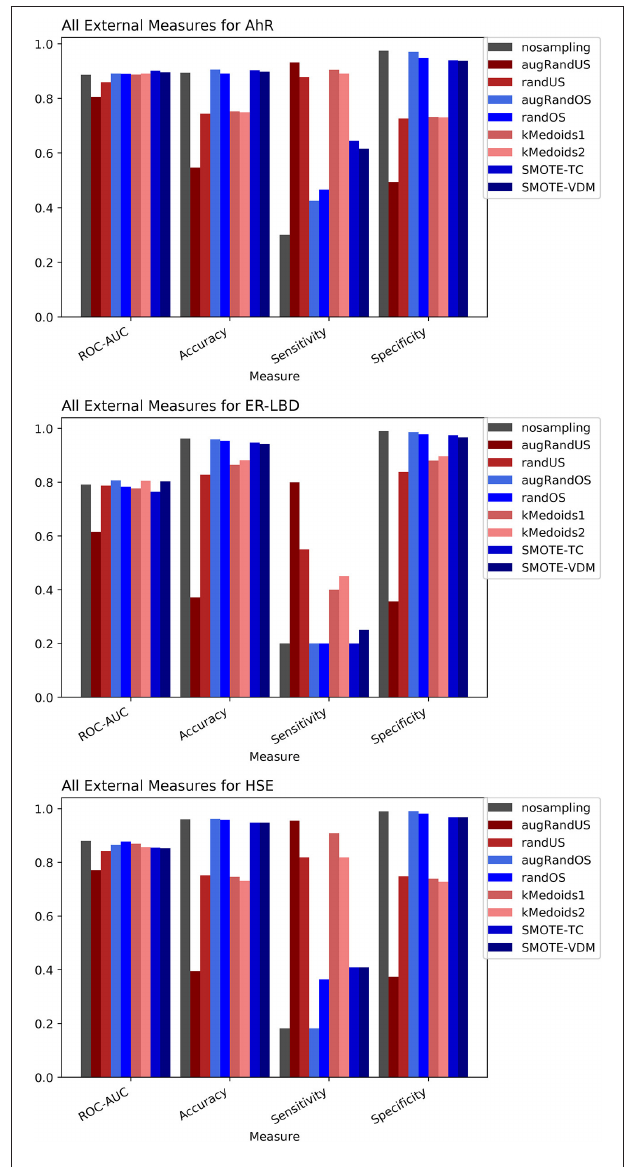
FIGURE 3 | Performance measures for external validation -AhR (A) , ER-LBD (B) , and HSE (C) models based on Random Forest Classifier and MACCS